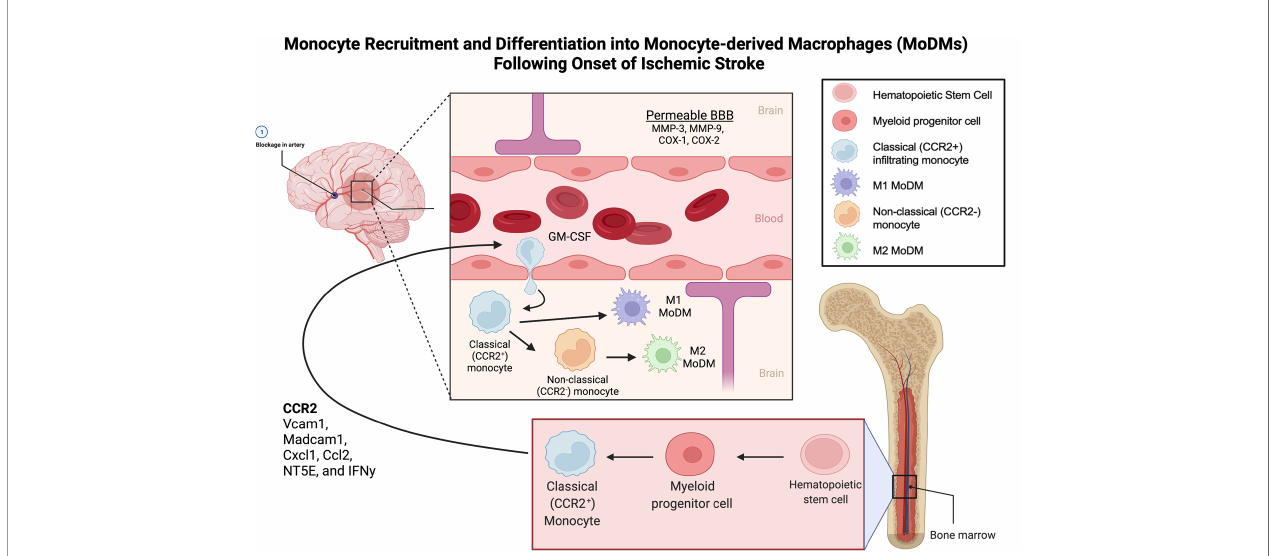
FIGURE 1 | Monocyte Recruitment and Differentiation into Monocyte-derived Macrophages (MoDMs) Following Onset of Ischemic Stroke. Monocytes originate from myeloid progenitor cells derived from hematopoietic stem cells in the bone marrow. Upon ischemic insult, the classical monocytes (CCR2+) are recruited to the area of in fl ammation through the release of CCR2, Vcam1, Madcam1, Cxcl1, Ccl2, NT5E, and IFNy. MMP-3, MMP-9, COX-1 and COX-2 facilitate the breakdown of the BBB allowing extravasation of the classical monocytes into the brain parenchyma. Monocyte migration is enhanced by GM- CSF. On arriving to the ischemic tissue, monocytes differentiate into MoDMs in response to chemokines, interleukins, and granule proteins produced by microglia, astrocytes, and neutrophils. In the ischemic site, classical monocytes can also lose expression of CCR2 to assume the non-classical phenotype. Classical monocytes primarily differentiate into M1, pro-in fl ammatory MoDMs while non-classical monocytes primarily differentiate into M2 anti-in fl ammatory MoDMs. MoDM, monocyte derived macrophage; GM-CSF, Granulocyte-macrophage colony-stimulating factor; BBB, Blood brain barrier; CCR2, C-C Motif Chemokine Receptor 2; Vcam1, Vascular Cell Adhesion Molecule-1; Madcam1, Mucosal Vascular Addressin Cell Adhesion Molecule 1; Cxcl1, C-X-C Motif Chemokine Ligand 1; Ccl2, C-C Motif Chemokine Ligand 2; NT5E, ecto-5 ′ -nucleotidase; IFNy, Interferon gamma; MMP-3, Matrix metalloproteinase-3;